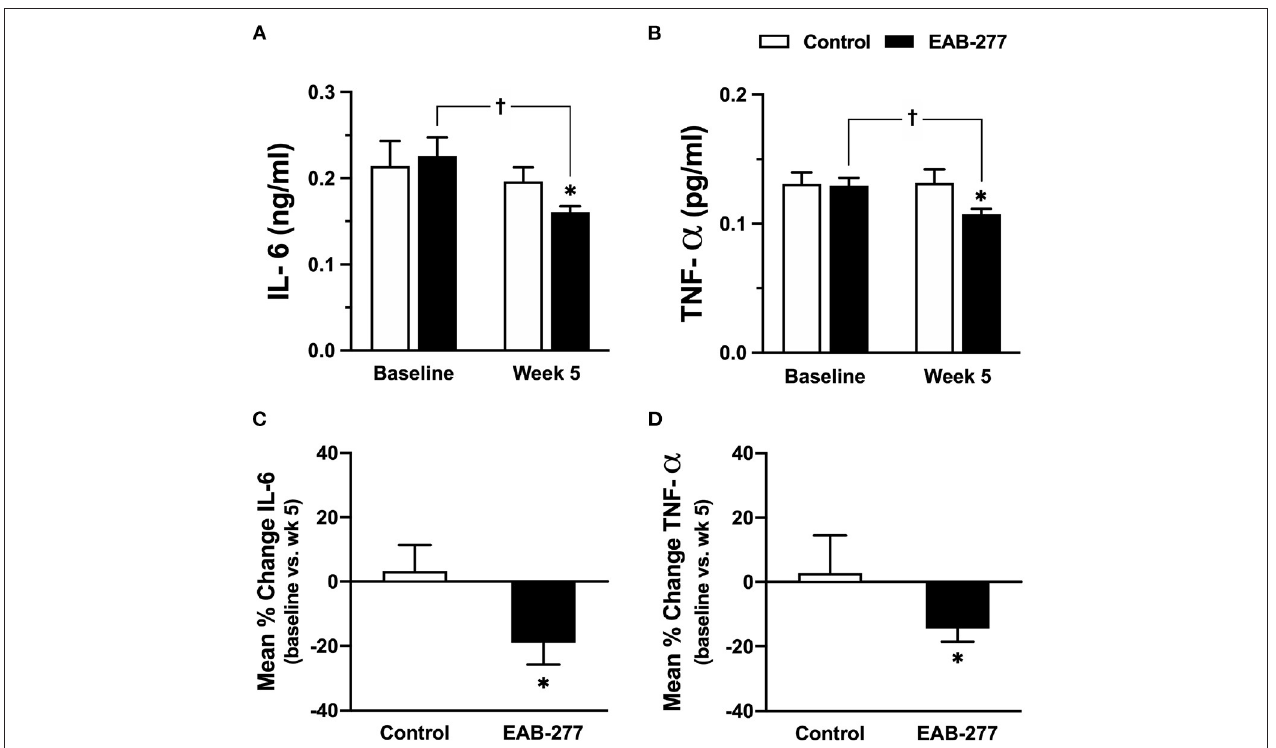
FIGURE 4 | Effect of standard treatment and EAB-277 ® on serum IL-6 and serum TNF- α in tracheal collapse dogs. (A) Serum IL-6 and (B) TNF- α were not different between groups at baseline, whereas serum IL-6 and TNF- α were decreased at week 5 in the EAB-277 ® group compared to baseline in the same group. Moreover, the mean percent change of serum IL-6 and TNF- α at week 5 in the treatment group was greater than the control group (C,D) . * P ≤ 0.05 compared to the control group. † P ≤ 0.05 compared to baseline in the same